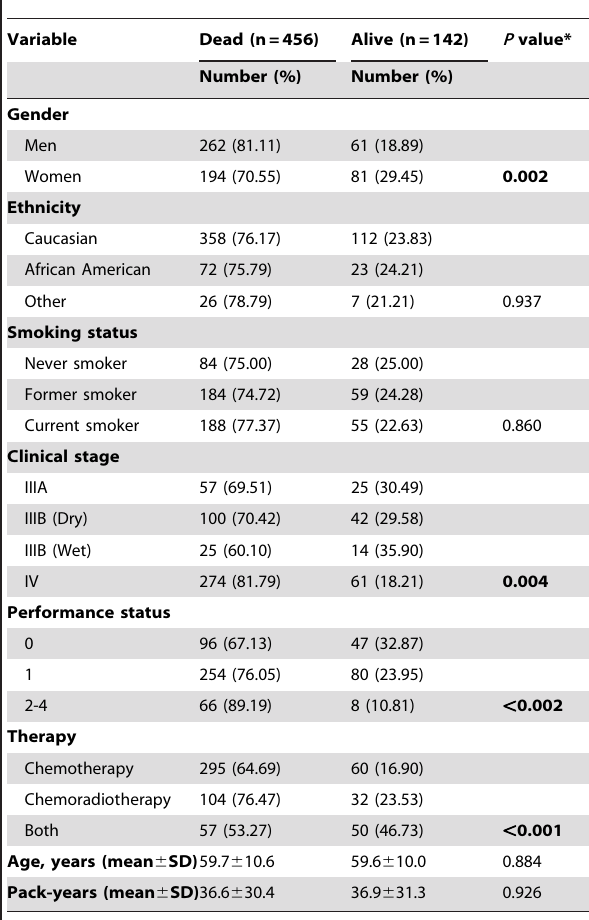
Table 1. Distribution of demographic and clinical variables by survival